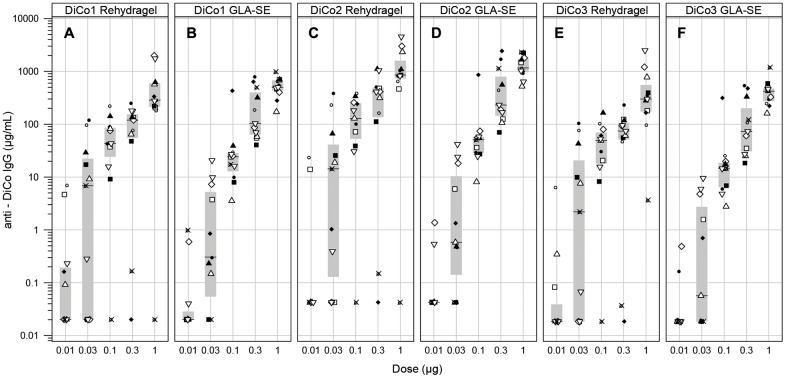
Seroconversion as a function of dose.Groups of 11 mice were immunized with indicated amounts of Drug Product formulated in either Rehydragel (Panels A, C and E) or GLA-SE (Panels B, D and F). On day 28 they were immunized again. Serum was collected on day 42 and ELISAs were performed using either PfAMA1 DiCo1 (Panels A,B), PfAMA1 DiCo2 (Panels C,D) or PfAMA1 DiCo3 (Panels E,F) as coating antigen. Individual mice within a treatment group are indicated by symbols, where the same symbol within a treatment groups represents the same animal for PfAMA1 DiCo1, PfAMA1 DiCo2 and PfAMA1 DiCo3, respectively.